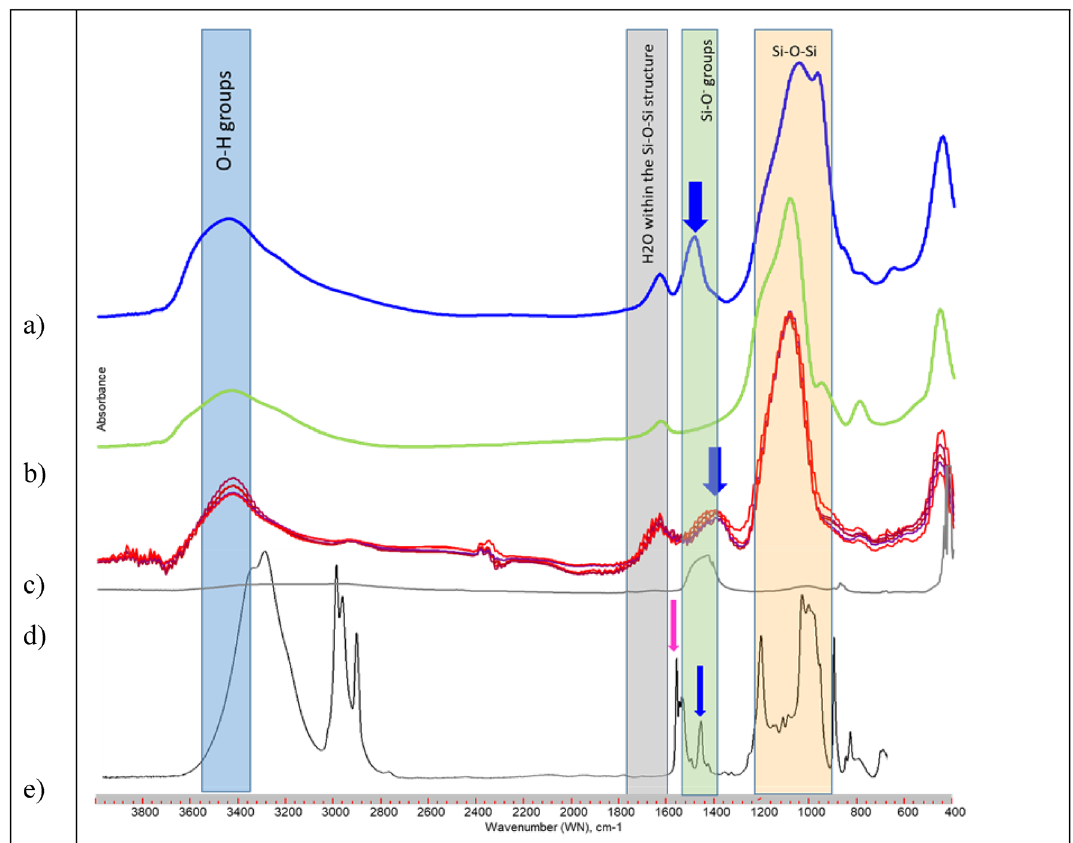
Figure 4. FTIR spectra of ( a ) ZEOfree, ( b ) bulk Sipernat 50 s, ( c ) water soluble Sipernat 50 s fraction (n = 6), ( d ) Na